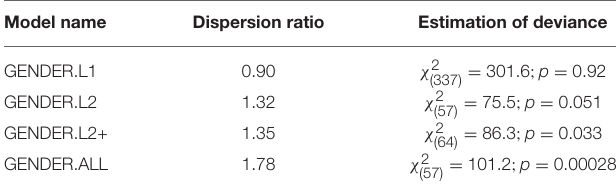
TABLE 6 | Dispersion ratio and deviance from 1 for models in case study 2.